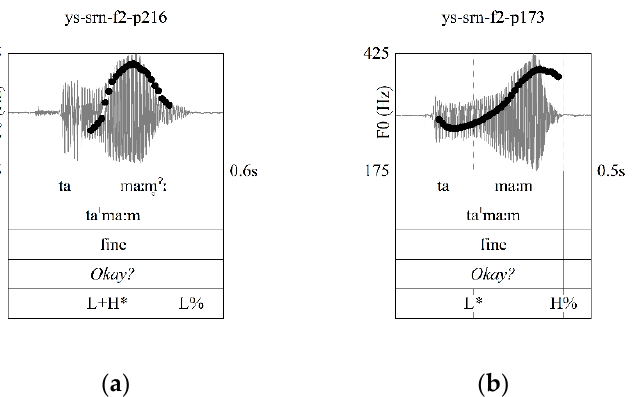
Figure 12. Single word W-coded turns of [tama:m] realized ( a ): with SA yes/no-question contour and with laryngealization; ( b ): with MSA yes/no-question contour and no laryngealization.